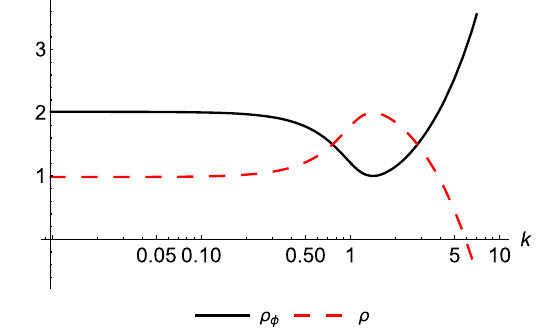
Fig. 1 Initial energy densities of the scalar field, ρ φ ( k ) = (cid:4) 0 | ˆ ρ (ψ) | 0 (cid:5) , and vacuum energy, ρ ( k ) , as a function of the mode’s wavenumber k for a 0 = 1 and h = 1. The sum of the densities is fixed because of the Friedmann constraint. Numerical inspection shows that ρ φ ( k (cid:13) 1 ) = 2 . 02, ρ φ ( k ≈ 1 . 41 ) = 1 . 00, and ρ φ ( k ≈ 3 . 90 ) = 2 . 02 where k ≈ 1 . 41 marks the minimum of ρ φ ( k ) and k ≈ 3 . 90 signify the wavenumber above which ρ φ ( k ) > 2 .